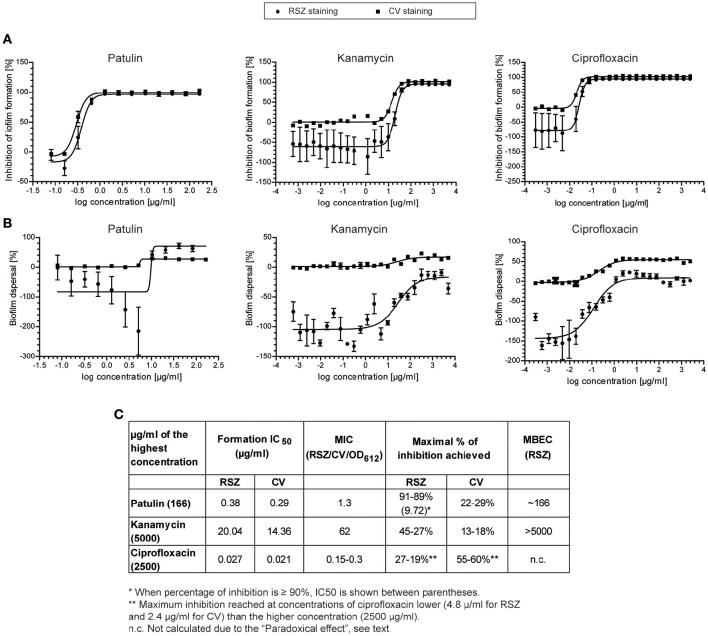
Dose-response curves of patulin, kanamycin, and ciprofloxacin. The inhibitory activity in biofilm formation assay (A) or in biofilm dispersal assay (B) was determined by RSZ (•) or CV (■) staining. Mean and standard error of mean of two independent experiments is shown. (C) IC50, MIC, and MBEC-values (μg/ml) for patulin and the two broad-spectrum antibiotics used are shown.